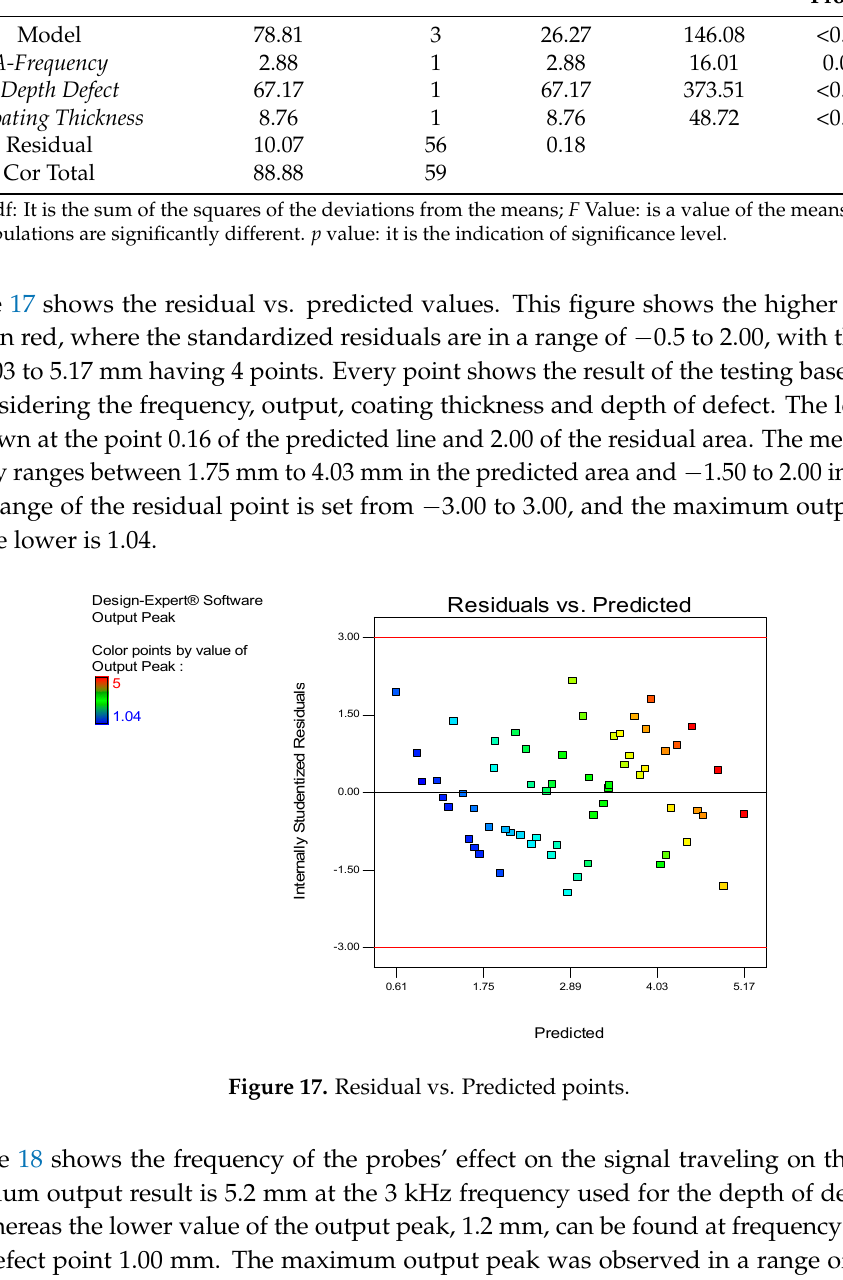
Figure 18. Relations between Depth of Defect, Frequency and Output Peak. The main factors that affect output peak are coating thickness and depth of defect, as shown in Figure 19. Most defects on the output peak are in the range of 3.15 mm to 4.5 mm and depth defects within 2.50 mm and 4.00 mm are shown in green, as per the graph below. From this graph, the dangerous situation or maximum crack (red color) was measured at 4.00 mm to 5.00 mm for depth of defect and at the coating thicknesses of 2.50 mm to 4.00 mm. The lower output measured is in the range of 1.00 mm to 2.00 mm in the depth of defect with a coating thickness of 1.00 mm to 2.50 mm.